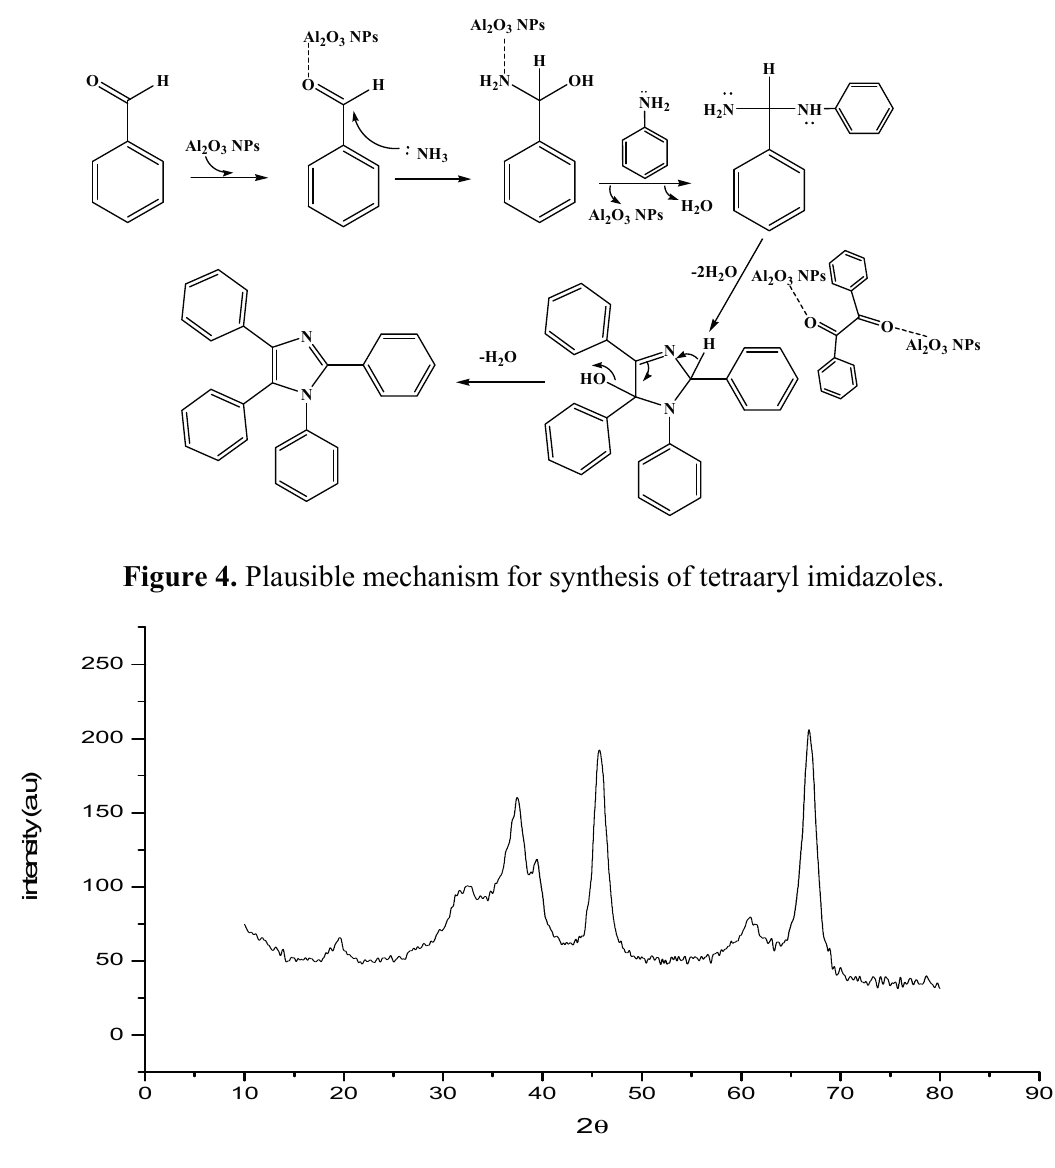
Figure 5. XRD pattern of recovered γ -Al 2 O 3 NPs after four runs.